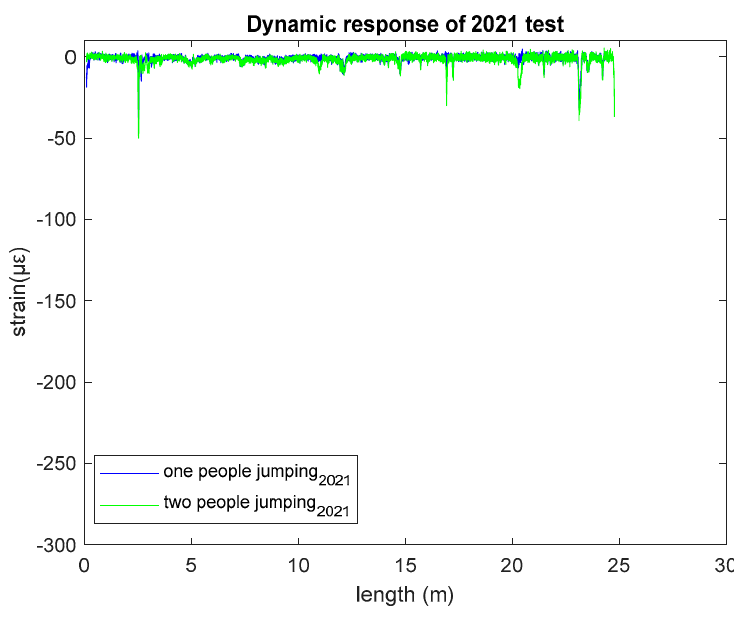
Figure 7. Dynamic response of 2021 test.